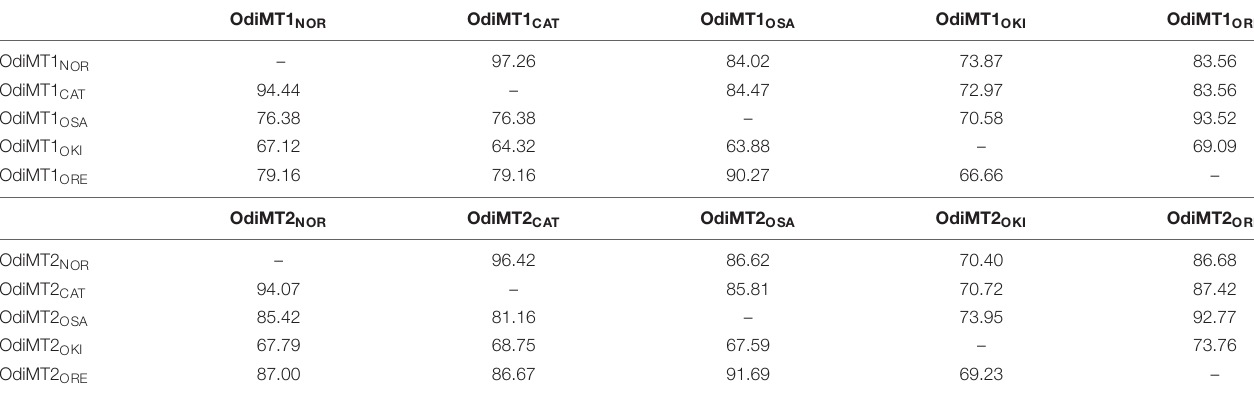
TABLE 2 | Percentage identity a of nucleotide (above diagonal) and amino acid sequences (below diagonal) of the OdiMT coding regions from five different O. dioica populations, Norway (NOR), Catalonia (CAT), Osaka (OSA), Okinawa (OKI), and Oregon (ORE).